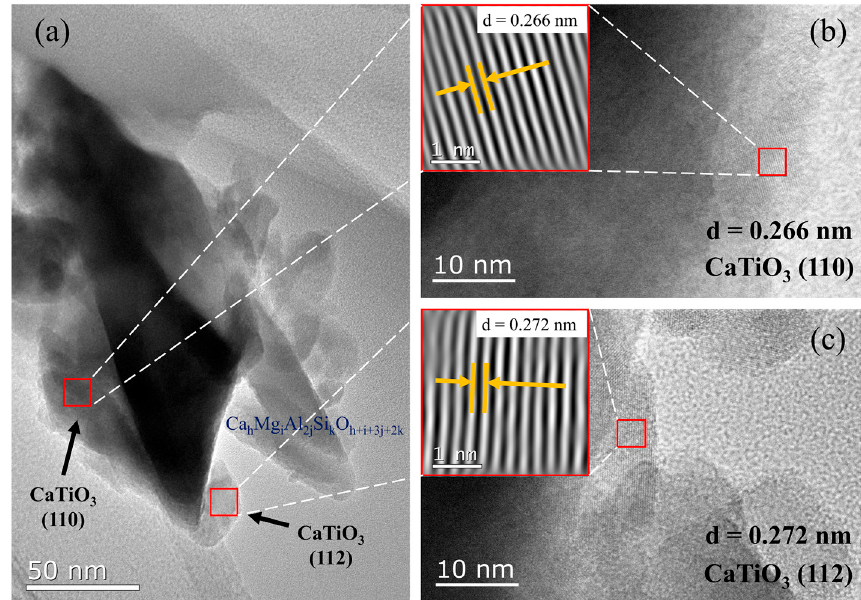
Figure 4. ( a ) TEM image of MM-CaTiO 3 ; ( b , c ) HRTEM image of CaTiO 3 .